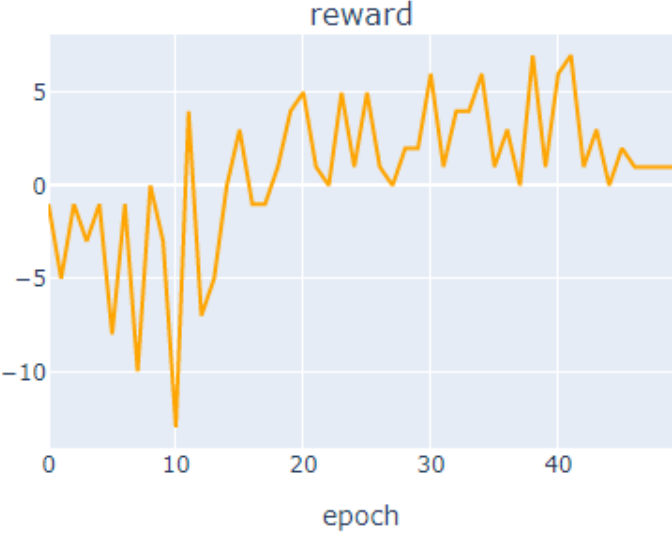
Figure 5. Deep Q Network-based intelligent autoscaler compensation value result.